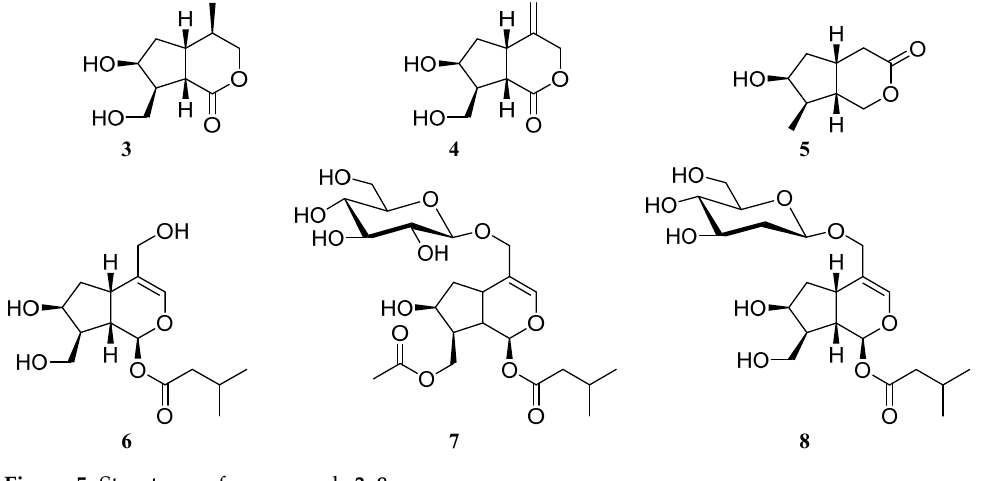
Figure 5. Structures of compounds 3 – 8 .